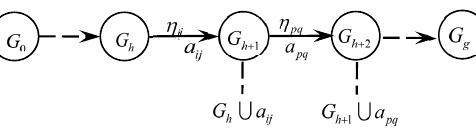
Figure 1. The construction process of a BN.